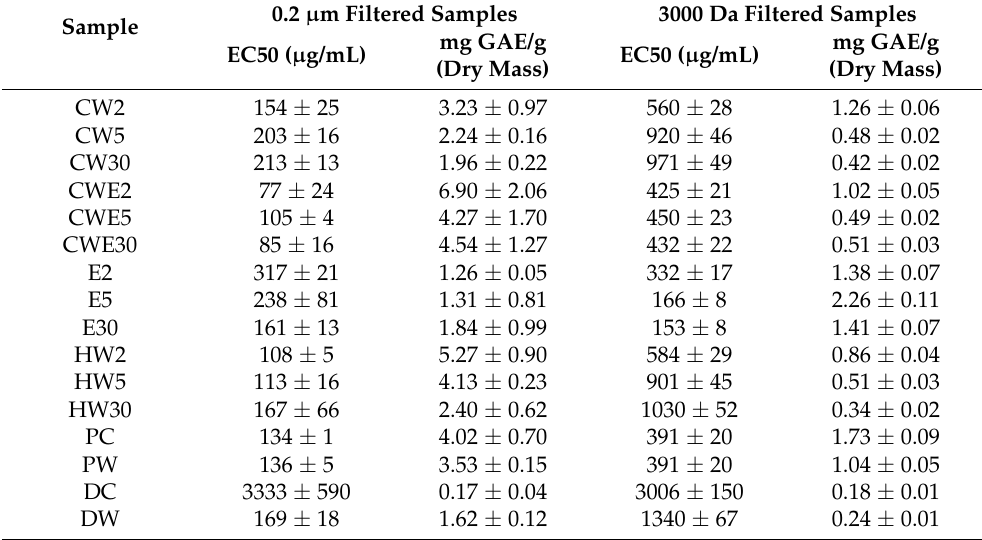
Table 6. DPPH test of bark (CW: cold water extraction; E: ethanol extraction; HW: hot water extraction with 2, 5, or 30 min extraction time), and debarking water (D) and bark press water (P) from the pulp and paper industry using a water recycling system with clarifier (C) or wastewater treatment plant (W). Samples were filtered through standard 0.2 µ m filters or 3000 Da filters. The results are expressed as the gallic acid equivalent antioxidant capacity (GAE) and as equivalent concentrations of test samples scavenging 50% of DPPH radical